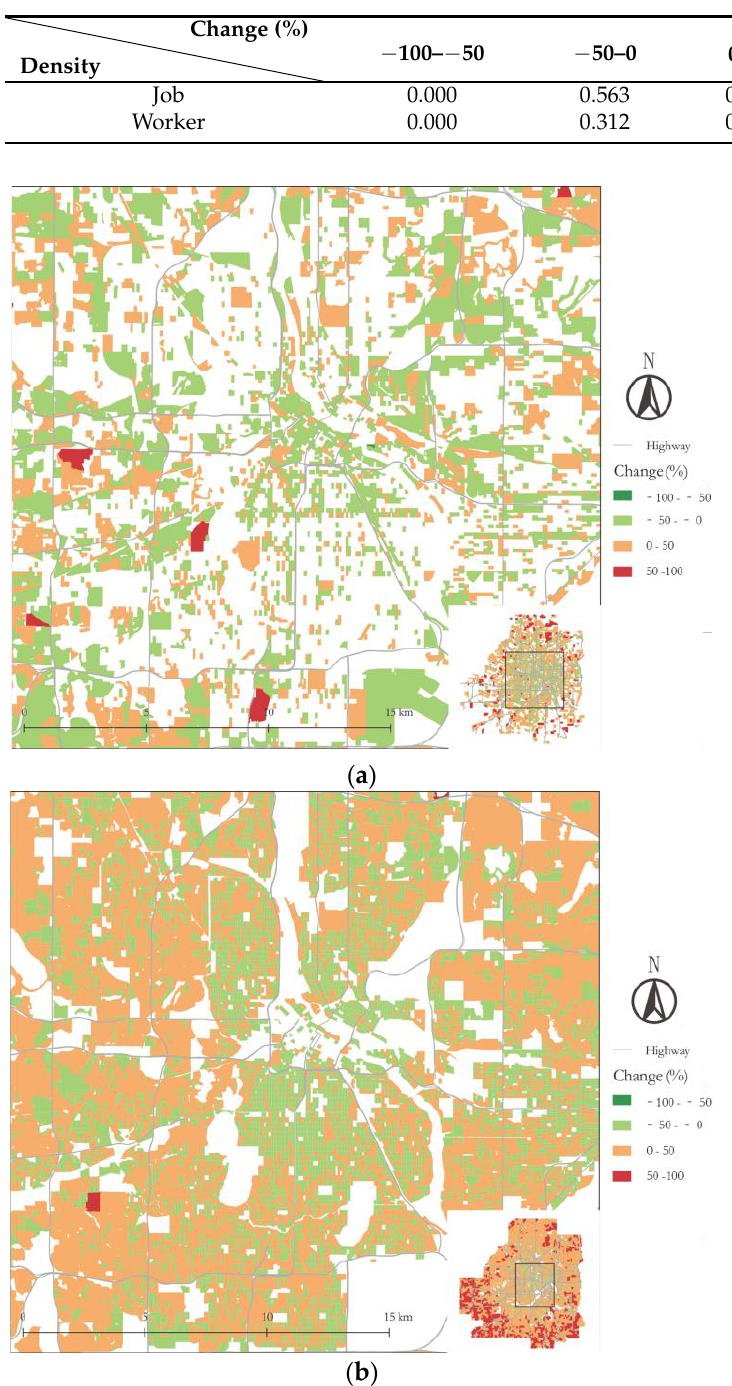
Figure 4. Spatial distributions of density changes between 2022 and 2017 for the Twin Cities: ( a ) change in job density; ( b ) change in worker density.